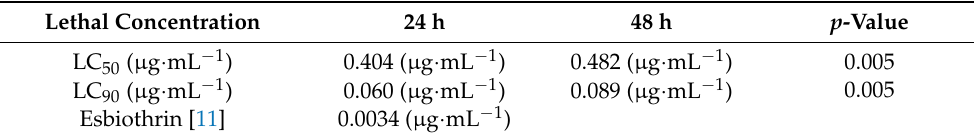
Table 1. PHEON Lethal Concentration against A. aegypti eggs.